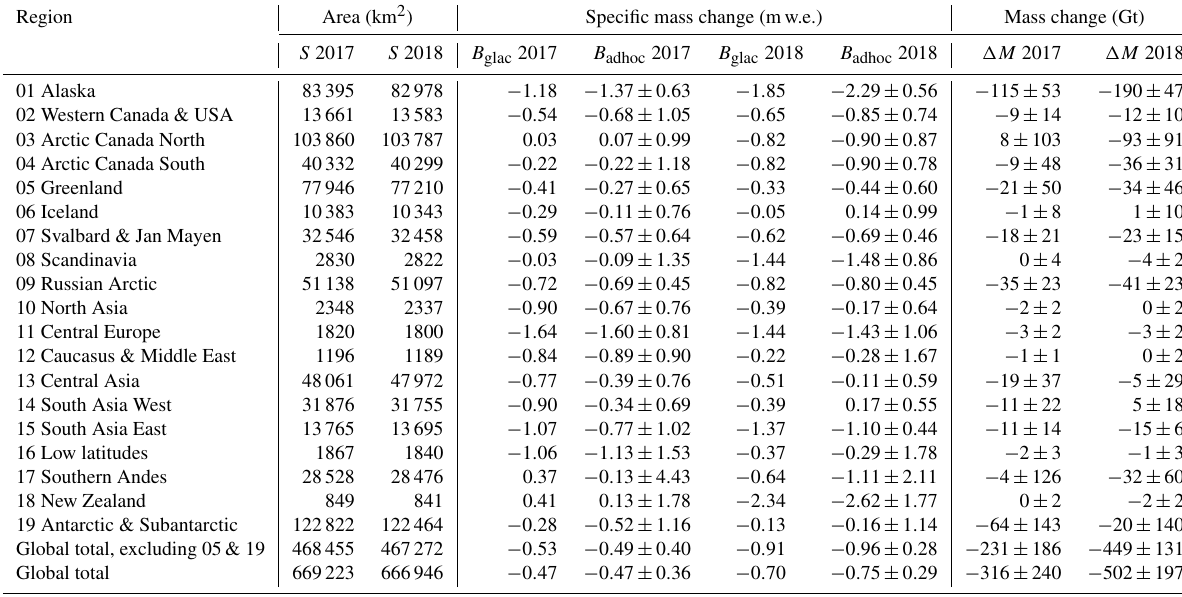
Table 1. Ad hoc estimates of glacier mass changes in 2016/17 and 2017/18. For both years, the table shows glacier areas ( S ) based on RGI 6.0 (2017) and corrected for annual area change rates from Zemp et al. (2019), specific mass changes calculated as arithmetic mean of the glaciological sample ( B glac ) and based on the ad hoc estimation ( B adhoc , Eq. 4), as well as anomaly-corrected mass change ( (cid:49)M , Eq. 6) for all regions and global totals. Global specific mass changes and related biases are calculated as area-weighted regional means. Uncertainties correspond to 95% confidence intervals. The annual global mass changes in 2016/17 and 2017/18 correspond to 0 . 9 ± 0 . 6